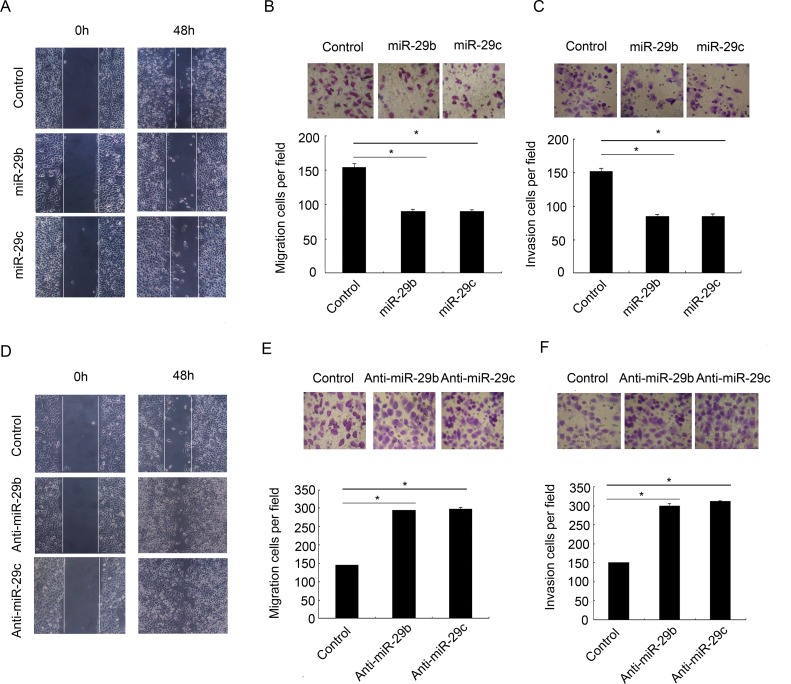
The effect of miR-29b/c on GC cell invasion and migration.(A) Wound healing assays of the confluent layers of negative control mimics or miR-29b/c mimics-transfected BGC-823 cells. Images were acquired at 0 and 48 hours after wounding. (B and C) Representative images (upper) and bar graphs (bottom) depicting the migration (B) and invasion (C) ability of BGC-823 cells after the 48-hour transfection of negative control mimics or miR-29b/c mimics (*P<0.05). (D) Wound healing assays on the confluent layers of negative control inhibitors or miR-29b/c inhibitors-transfected BGC-823 cells. Images were acquired at 0 and 48 hours after wounding. (E and F) Representative images (upper) and bar graphs (bottom) depicting the migration (E) and invasion (F) ability of BGC-823 cells after the 48-hour transfection of negative control inhibitors or miR-29b/c inhibitors (*P<0.05). Number of cells that migrated or invaded was counted in five fields. The migration and invasion rate are represented as cell number per field.